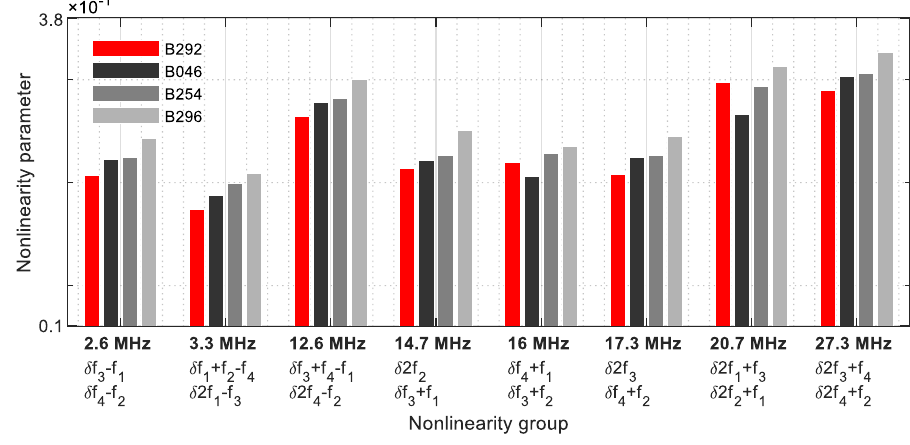
Figure 33. Nonlinearity parameter — δ G2 .